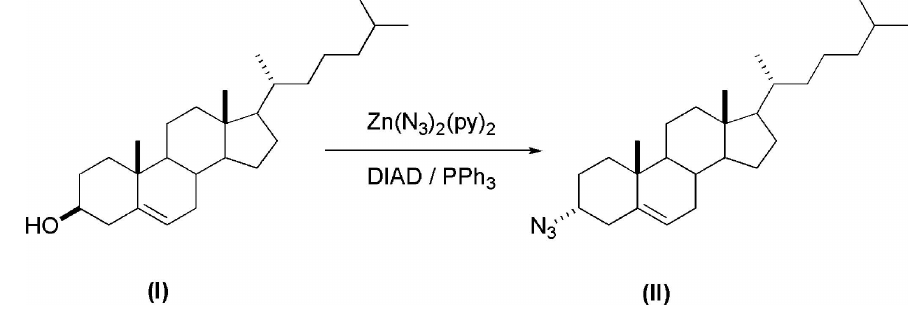
Figure 2 The formation of the title